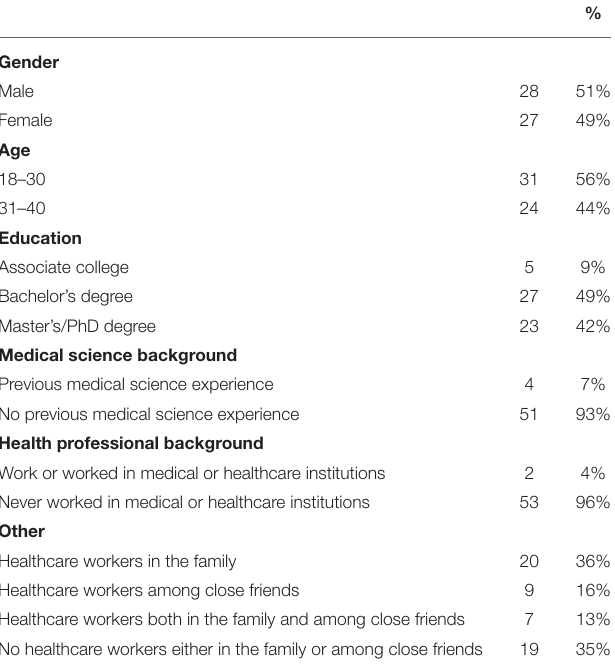
TABLE 1 | Demographic information on